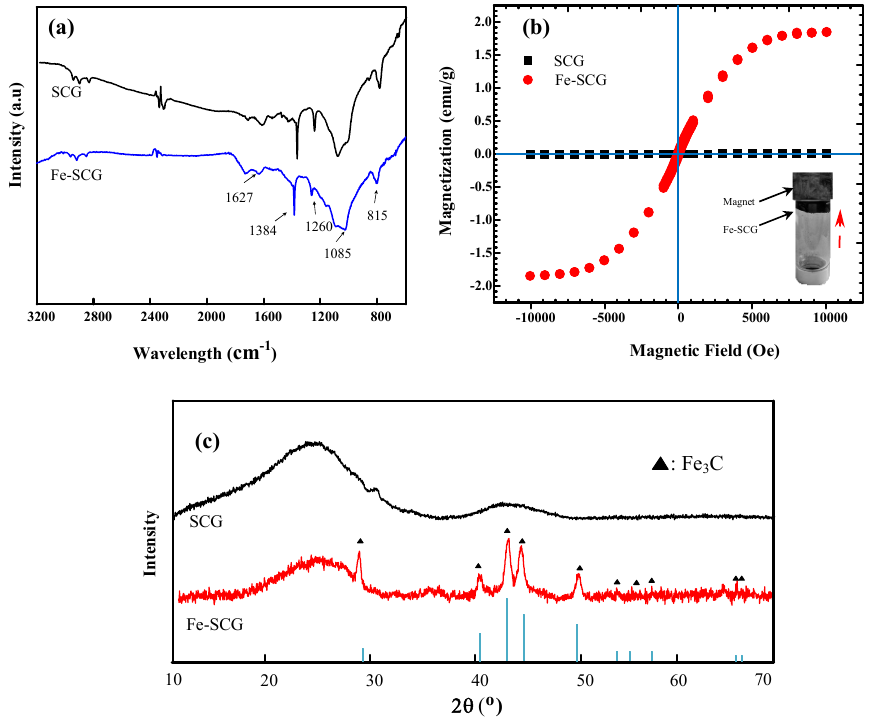
Figure 2. Fourier transform-infrared (FITR) data ( a ), magnetic hysteresis ( b ) and X-ray diffraction (XRD) patterns ( c ) for SCG and Fe ‐ SCG.